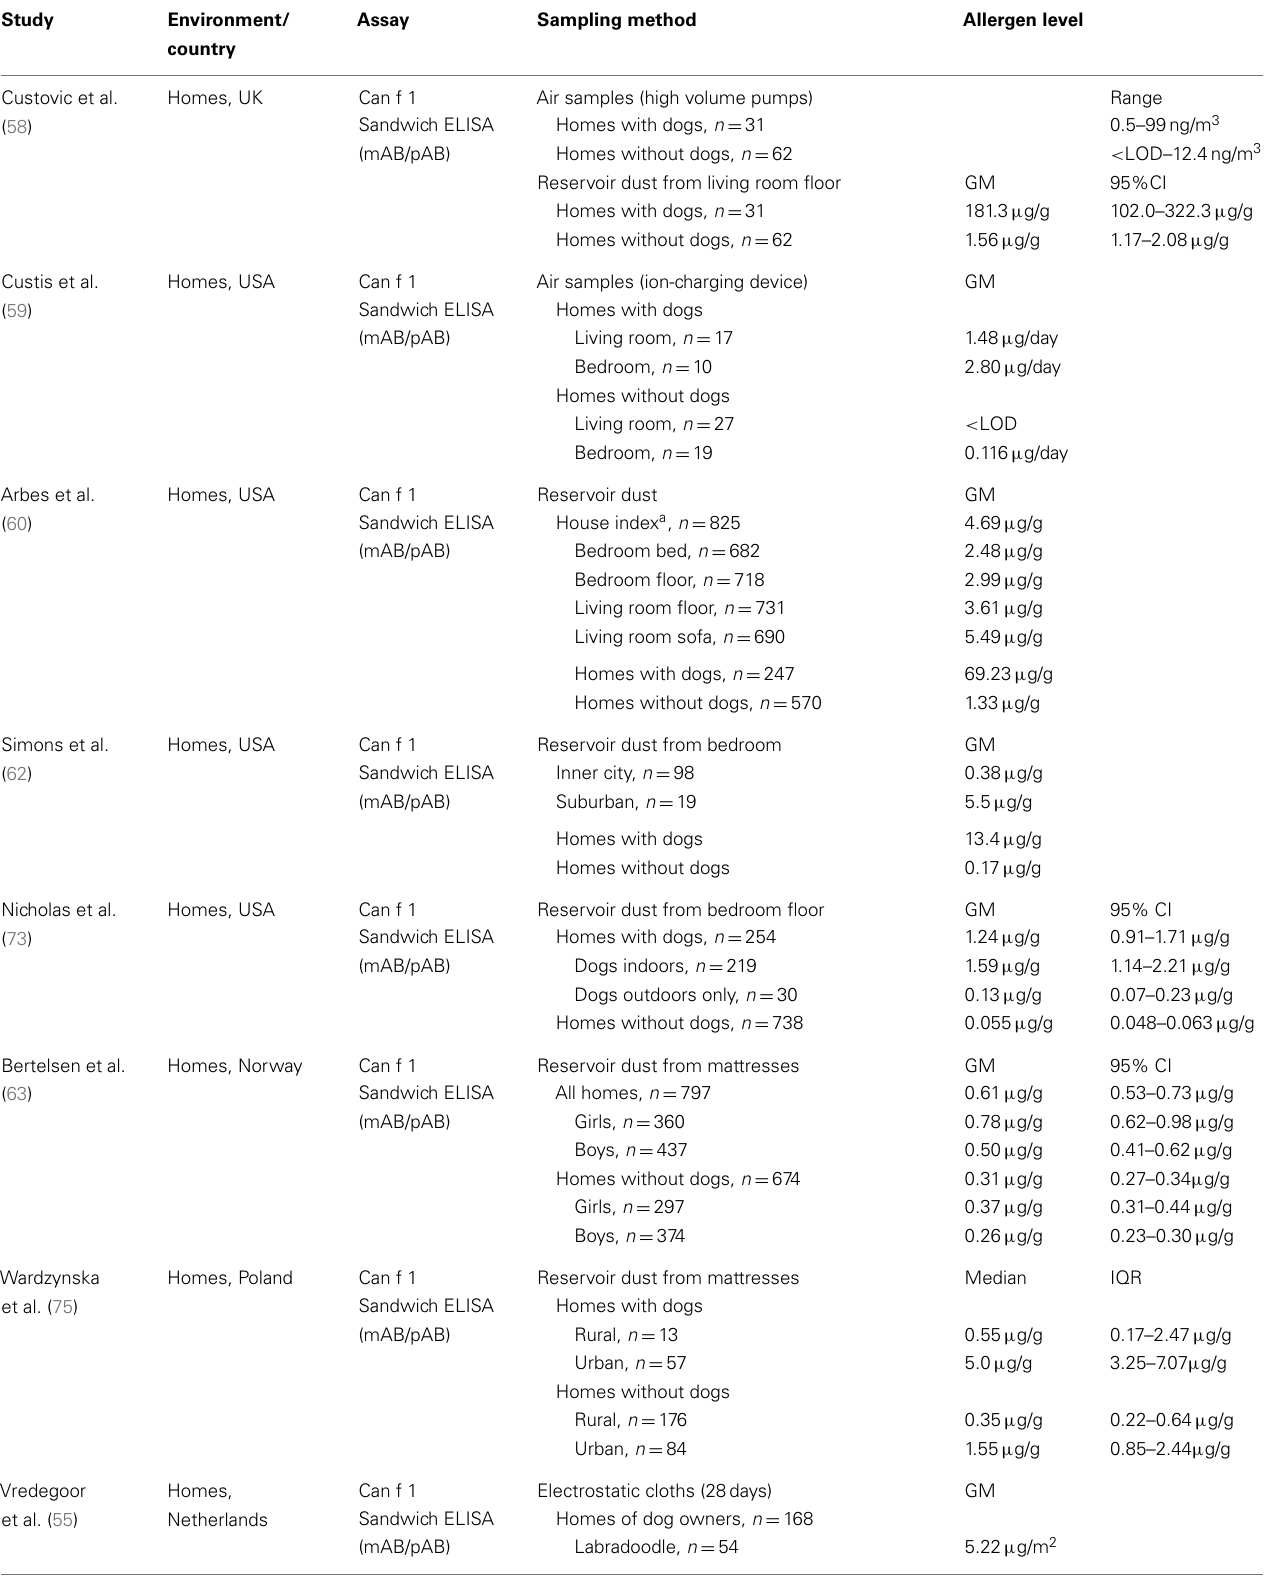
Table 2 | Studies related to exposure assessment to dog allergen